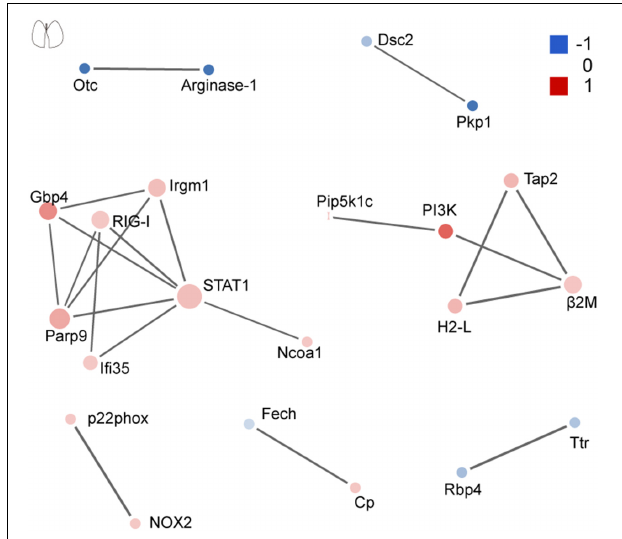
FIGURE 7 | Protein–protein interaction analysis of dysregulated proteins in the lung. The size of the nodes corresponds to the number of interacting proteins, whereas the different colors represent the regulation type and magnitude of protein changes. Red color represents upregulation, and blue color represents downregulation. The full list of key driver proteins can be found in Supplementary Table 4